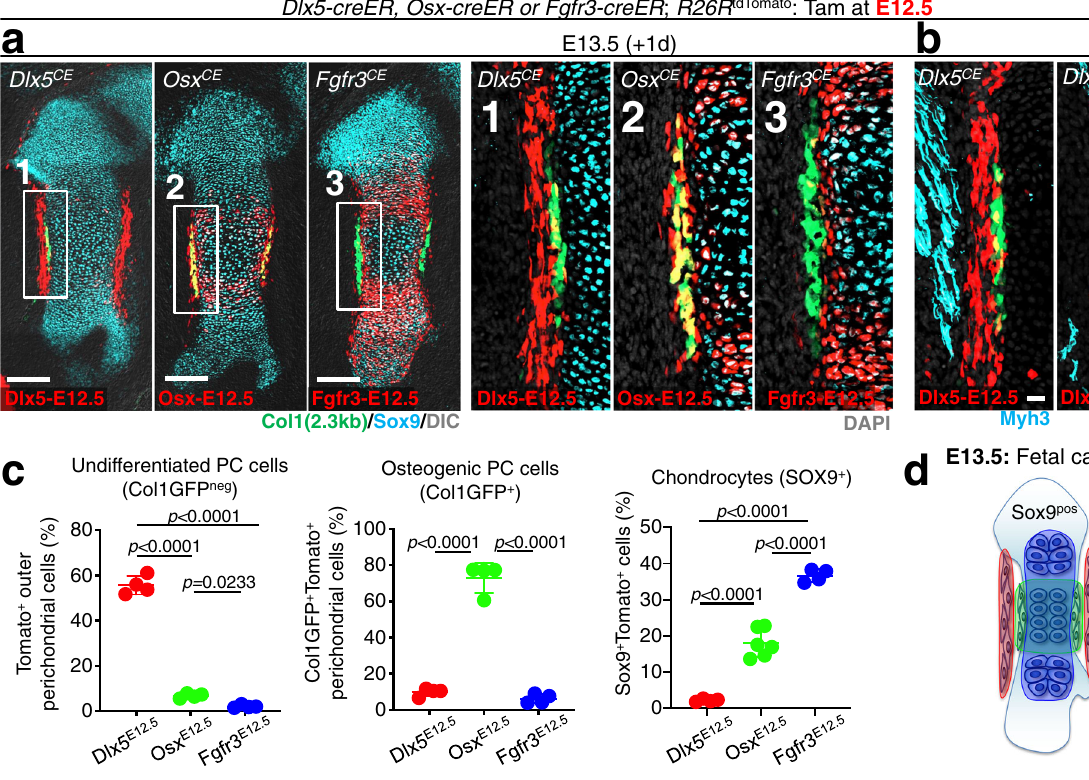
Fig. 2 | Dlx5-creER marks early perichondrial cells of the fetal cartilage. a – d LocalizationofDlx5-creER + ,Osx-creER + ,orFgfr3-creER + cellsatE13.5(pulsedat E12.5), visualized by cre -inducible R26R tdTomato reporter, with Col1a1(2.3kb)-GFP reporterstomarkosteoblasts. a E13.5cartilagetemplateimmunostainedforSOX9. Left panels: Scale bar: 200 µ m. Right panels: magni fi ed view of the boxed areas (1 – 3). n =4 mice per each group. b Col1a1(2.3kb)-GFP ; Dlx5-creER ; R26R tdTomato perichondria at E13.5, immunostained for MYH3 (skeletal muscles, left) or EMCN (endothelial cells, right). Grey: DAPI. Scale bar: 20 µ m. n =4 mice per each group. c Quanti fi cation of Dlx5-creER + , Osx-creER + , or Fgfr3-creER + tdTomato + cells. Left: